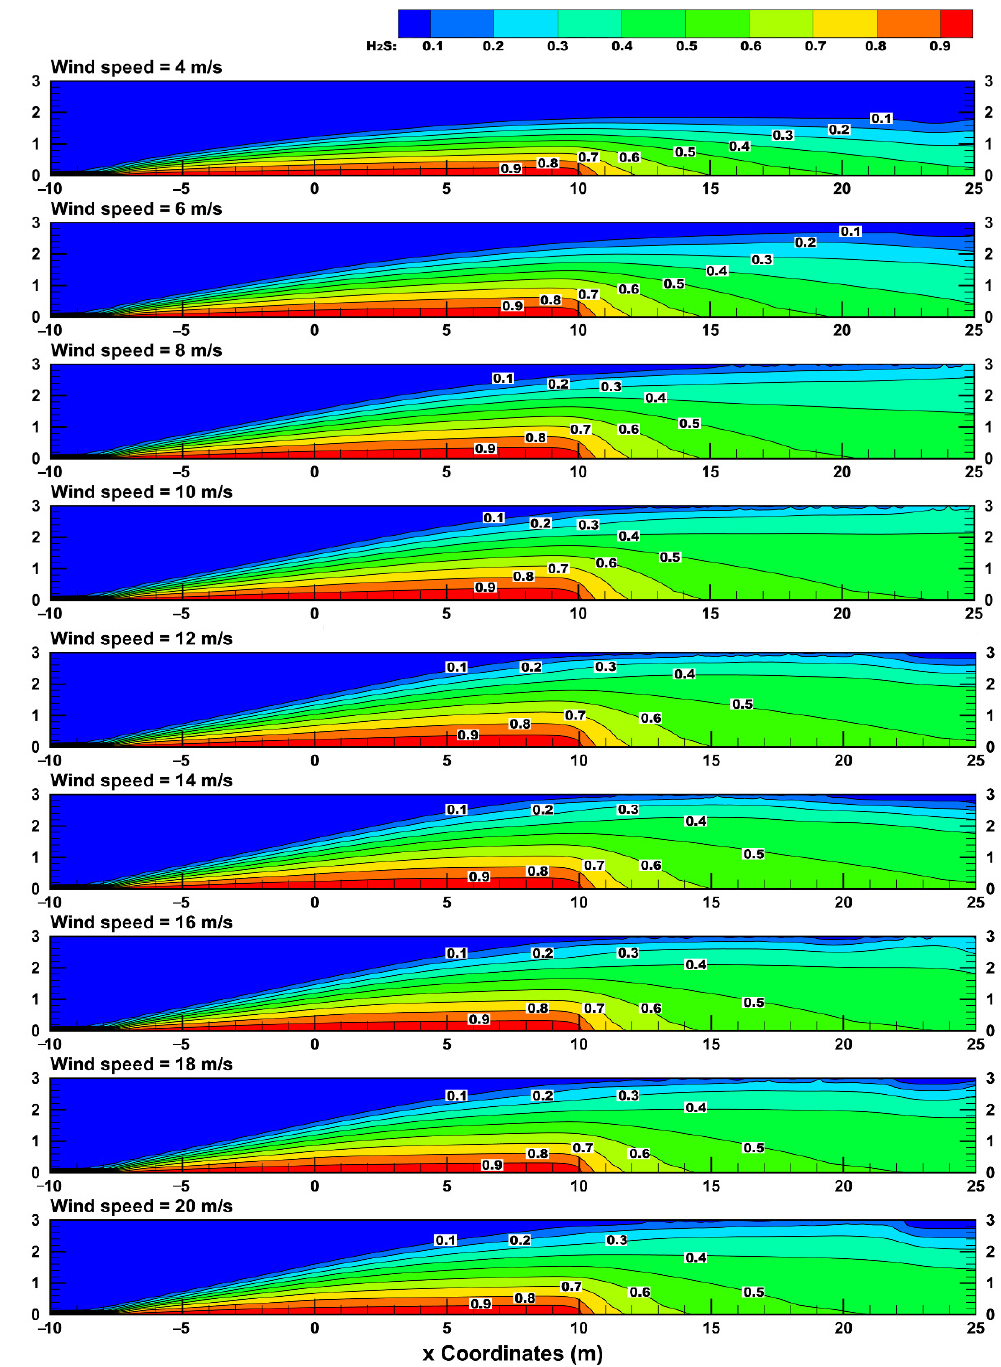
Figure 6. H 2 S plume of wind speed changing from 4 m/s to 20 m/s, controlling temperature at 298 K.